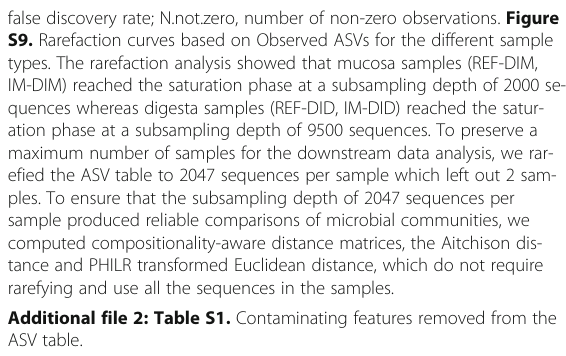
Additional file 2: Table S1. Contaminating features removed from the ASV table. Additional file 3: Table S2. The prevalence of core ASVs in different sample